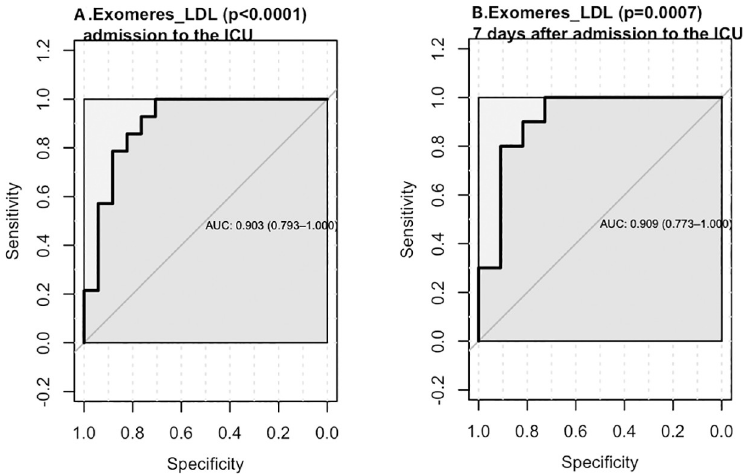
Fig 2. ROC analysis for analytes in blood plasma of patients with the Delta variant: A. ExoM_LDL (admission to the ICU), B. ExoM_LDL (7 days after admission to the ICU).